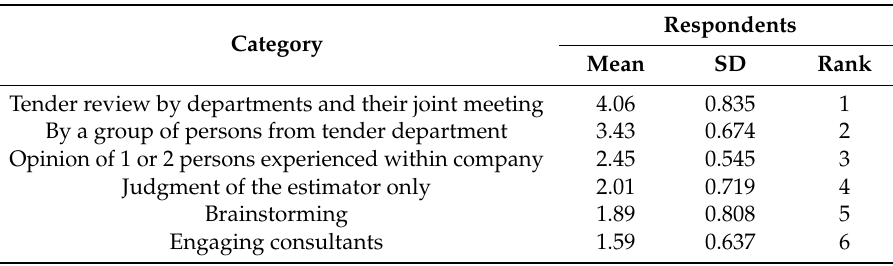
Table 5. Company procedure for risk identification.